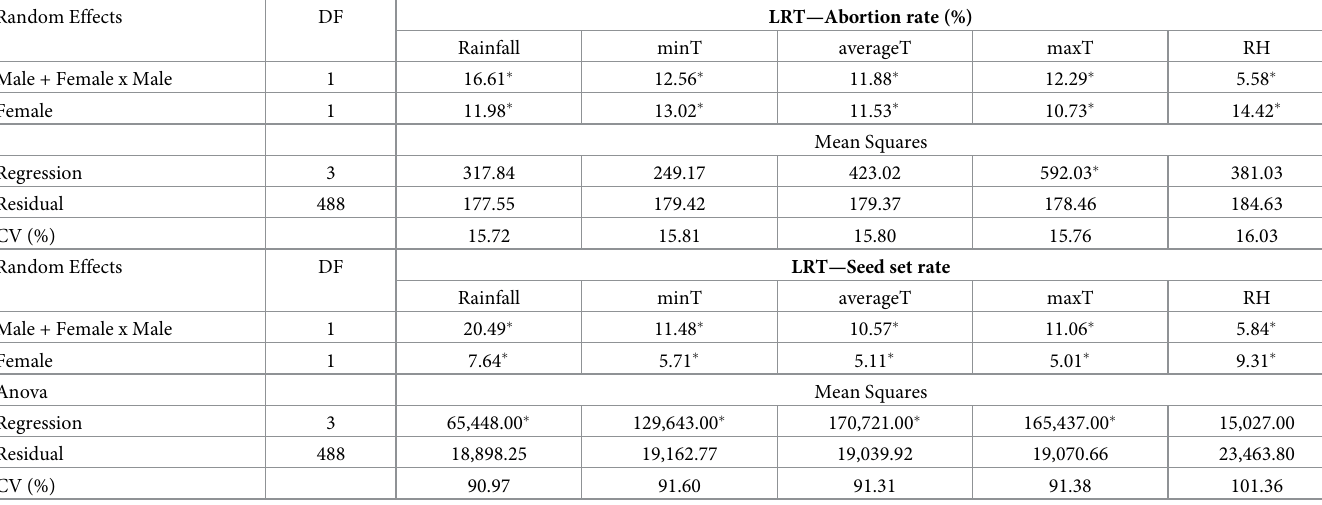
Table 2. Cubic regression analysis for seed setting and abortion rates with environmental variables in controlled crossings involving 91 cassava parents. Random